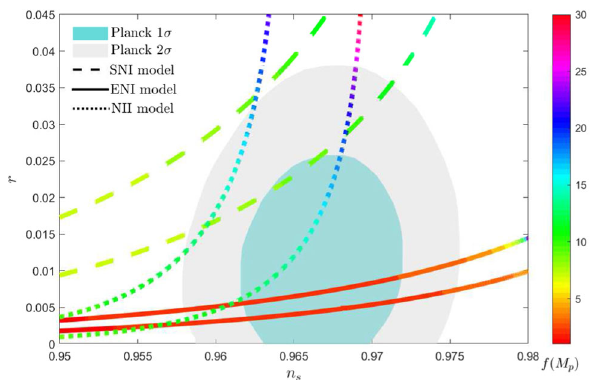
Fig. 2 Therelationshipbetween r and n s forthreesingle-fieldNImod- els under the special case ω re = 1 and the constraints of the amplitude 3 of scalar fluctuations. The dashed line, solid and dotted lines represent the relationship between n s − r under the SNI model, ENI model, and NII model, respectively. The colored gradient graph corresponds to the value of decay constant varying from 1 M p to 30 M p . In addition, the lightblueandlightgreybroadbandcorrespondtothelatestcombination 1 σ and 2 σ experiment errors of BAO, BICEP/KECK, and Planck data, respectively